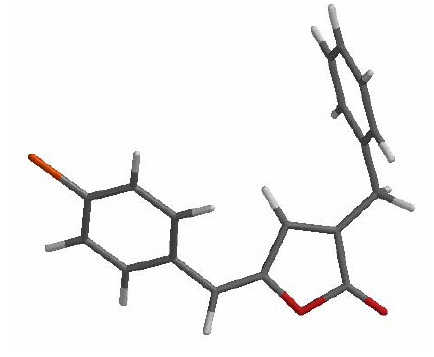
Scheme 6. Structures of the Z and E minimum energy conformers for compounds 8 and 14 . Oxygen, hydrogen, bromine, and carbon atoms are, respectively, red, white, orange and